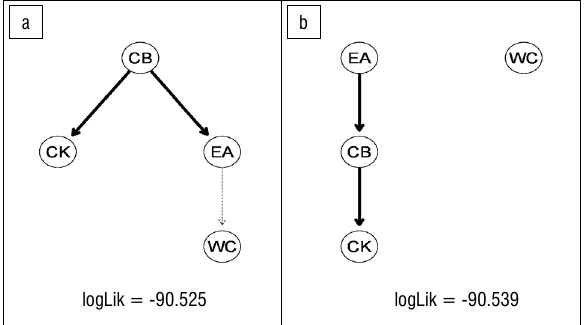
Figure 1: Causal models of the latent variables. The weights of the paths are proportional to the degree of confidence in the path, based on a Monte-Carlo simulation analysis (800 000 permutations). All effects are positive, and both models are plausible descriptions of causal influences based on Shipley’s C -test (see the